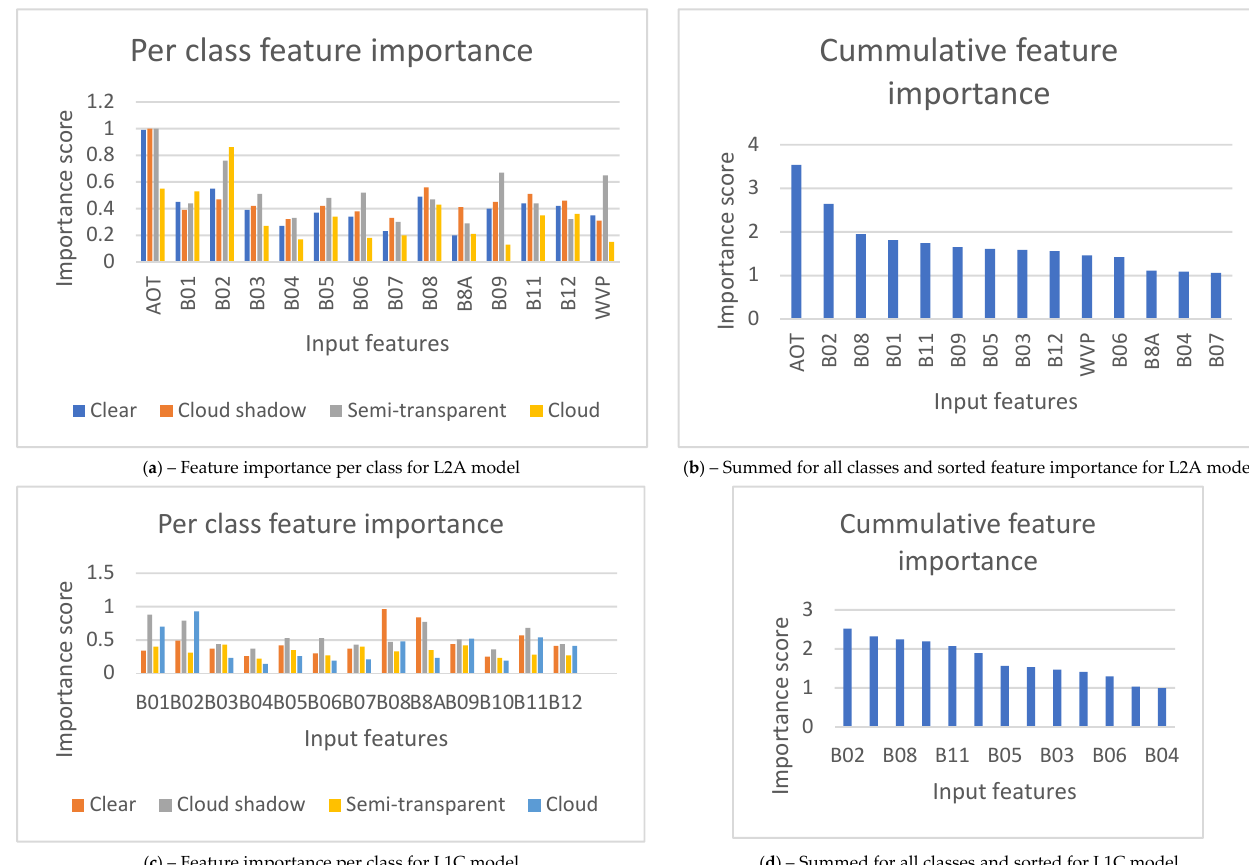
Figure 11. Feature importance obtained by deleting input features during inference for L2A model: ( a ) feature importance per class; ( b ) sorted feature importance, summed up for all the classes, and for L1C model: ( c ) feature importance per class; ( d ) sorted feature importance, summed up for all the classes.